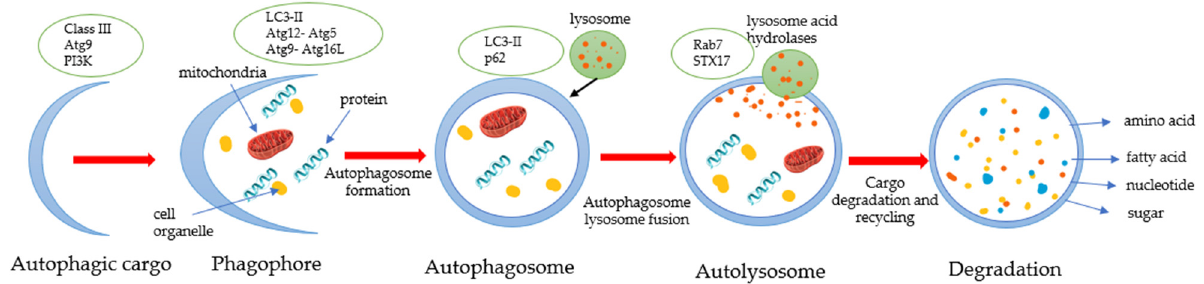
Figure 4. Process of autophagy. Class III PI3K mediates the production of PI3P, a key lipid-signaling molecule required for autophagosome formation.